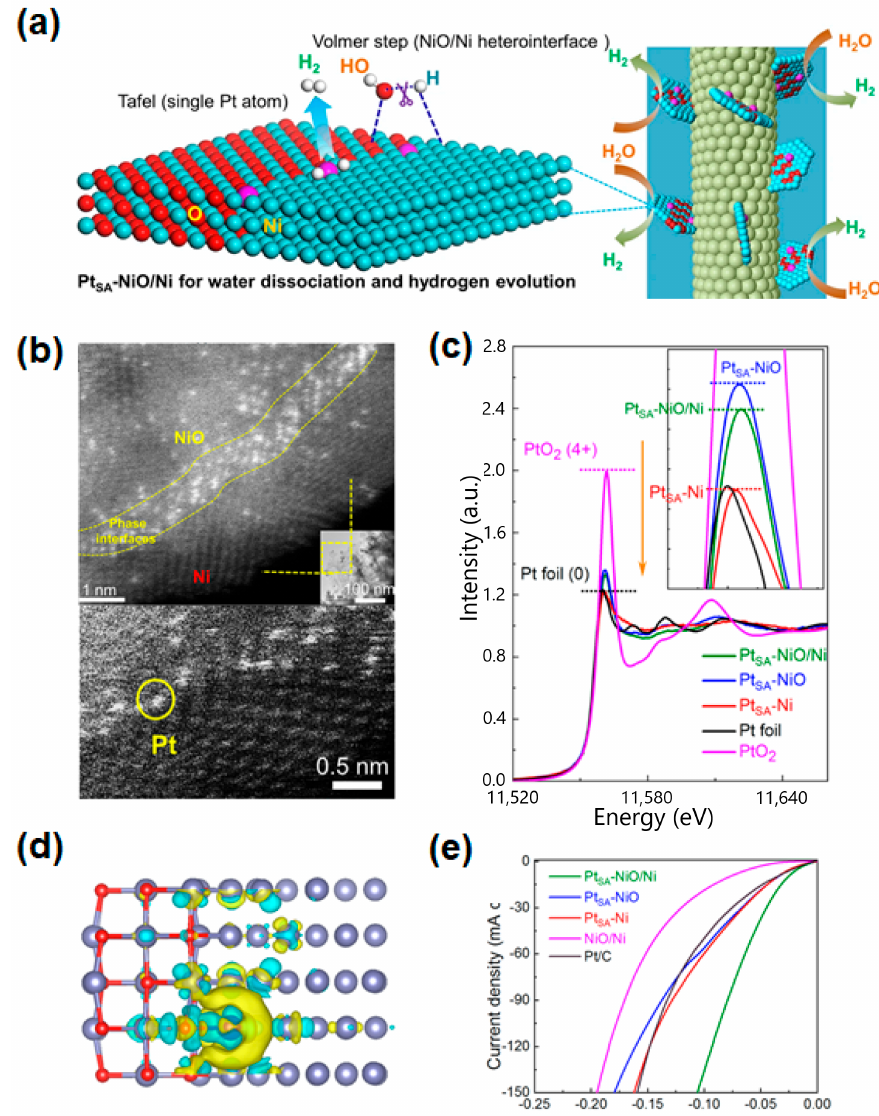
Figure 3. ( a ) The mechanism of the Pt SA -NiO/Ni network as an efficient catalyst toward large-scale water electrolysis in alkaline media. ( b ) HAADF-STEM image of Pt SA -NiO/Ni. ( c ) XANES spectra and calculated Pt oxidation states derived from ∆ XANES spectra of Pt SA -NiO/Ni, Pt SA -NiO, and Pt SA -Ni, with Pt foil given as a reference. ( d ) Computational models and localized electric field distribution of a Pt SA -NiO/Ni. ( e ) LSV curves of Pt SA -NiO/Ni, Pt SA -NiO, Pt SA -Ni, NiO/Ni, and Pt/C for HER. Reprinted (adapted) from reference [136], copyright (2021) Springer